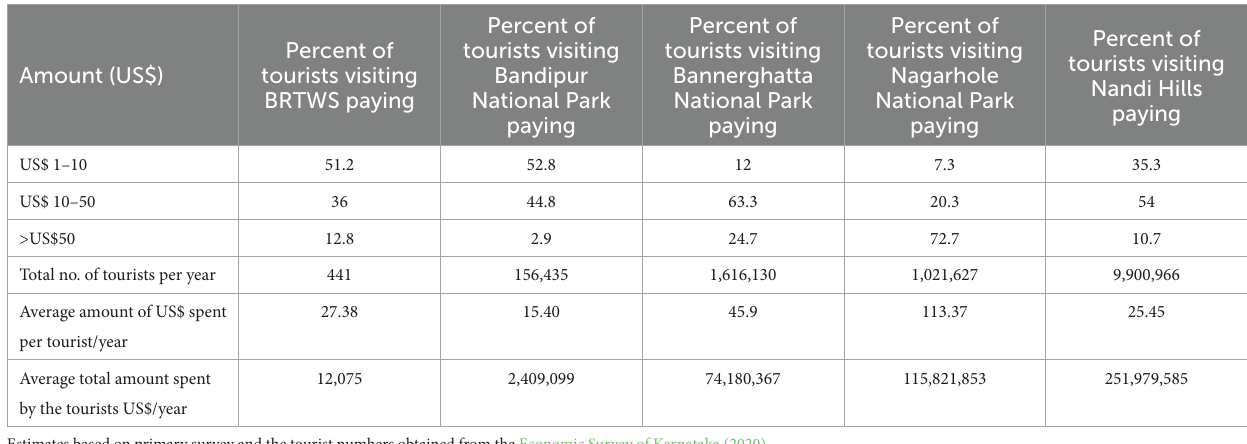
TABLE 5 The amount spent by each tourist while visiting the case study protected